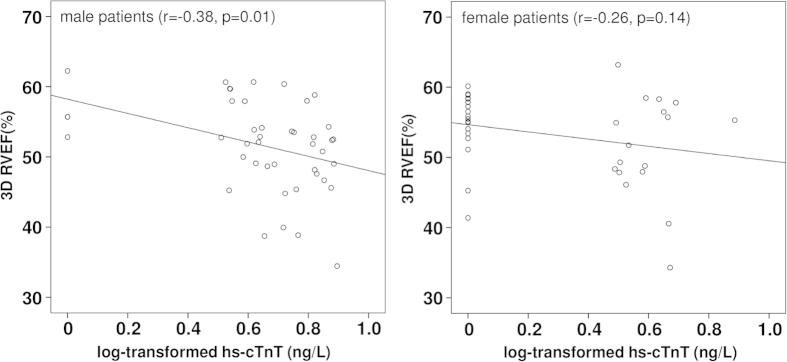
Scatter plots showing a negative correlation between log-transformed hs-cTnT levels and echocardiographically-derived right ventricular (RV) ejection fraction (EF) in male and female patients.